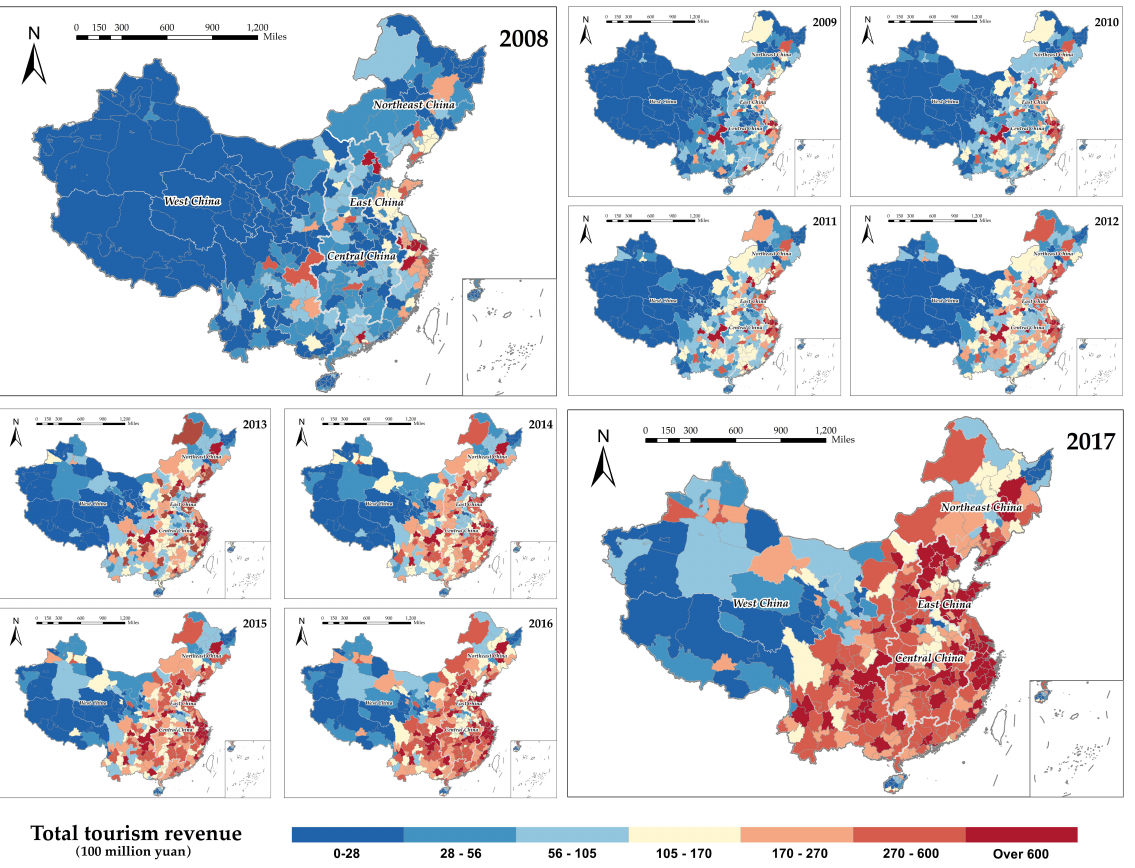
Figure 6. Estimated spatiotemporal maps for showing dynamic variations of city-level tourism development across China from 2008 to